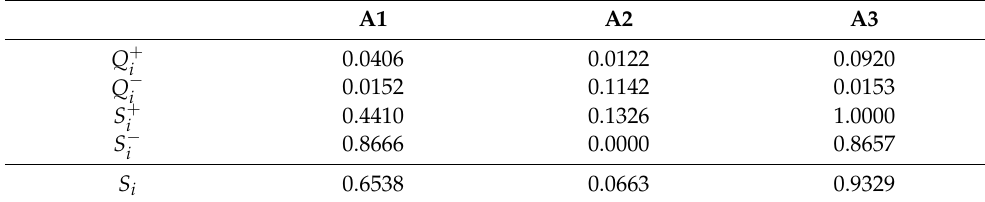
Table 6. The weighted normalized sum of PDA and NDA and the appraisal